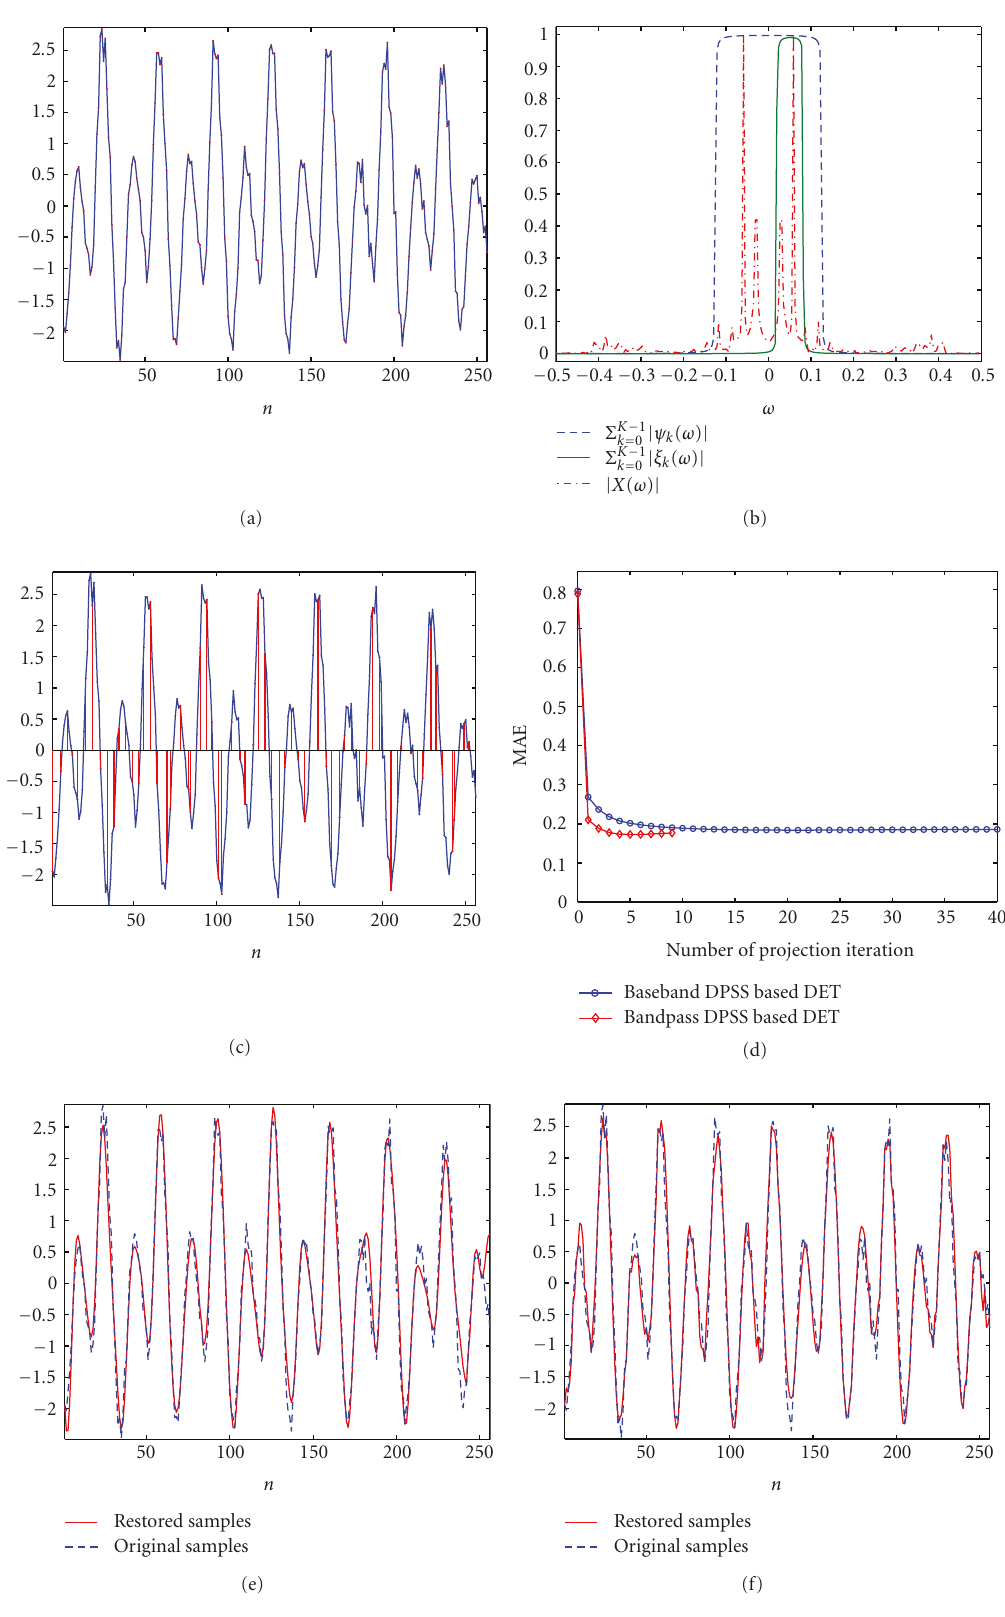
Figure 7: Restored results for the speech signal. (a) Speech signal, (b) spectrum of speech, baseband, and bandpass DPSS, (c) irregularly spaced subsamples ( L = 4, τ ∼ N (0,1 / 2)), (d) convergence behaviours, (e) restored signal by baseband DPSS- ( K = 64) based DET, and (f) restored signal by bandpass DPSS- ( K = 16, W c = 0 . 05) based